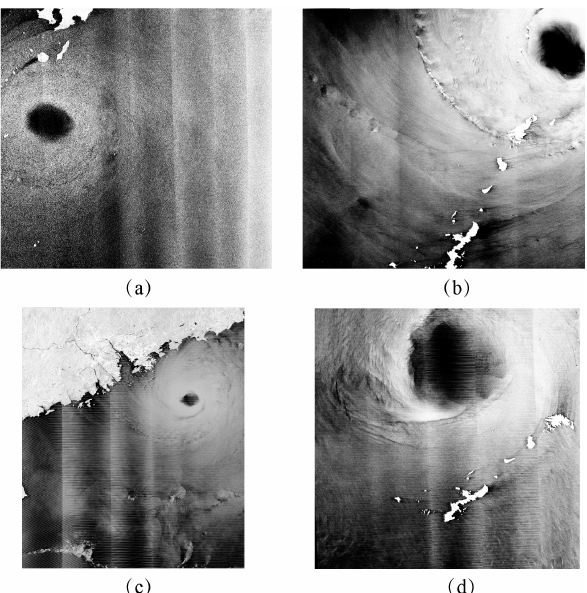
Figure 3. Three VH-polarization GF-3 SAR images taken during the period of three typhoons. ( a ) The image from typhoon Noru acquired in GLO mode on 4 August 2017 at 09:12 UTC. ( b ) The image from typhoon Noru acquired in WSC mode on 4 August 2017 at 21:26 UTC. ( c ) The image from typhoon Hato acquired in WSC mode on 22 August 2017 at 22:23 UTC. ( d ) The image from typhoon Talim acquired in WSC mode on 16 September 2017 at 09:34 UTC.